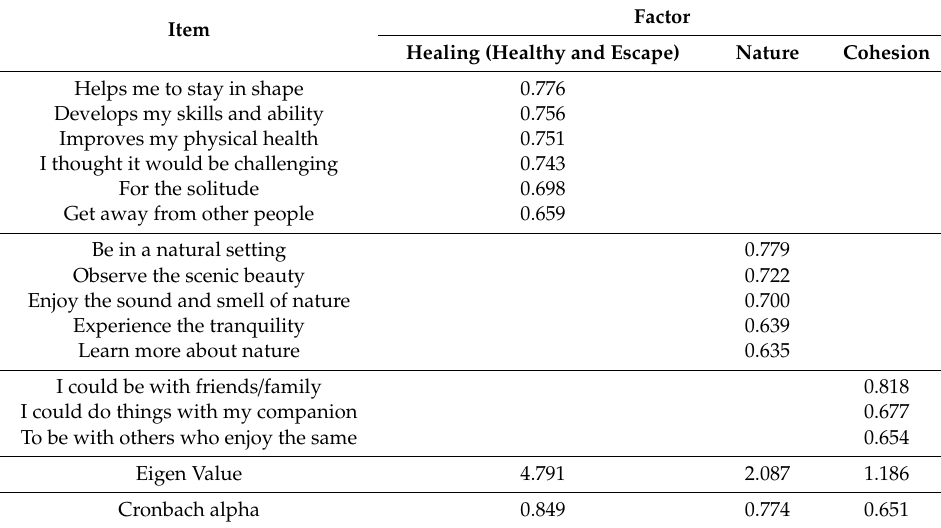
Table 2. Motivation factor analysis.